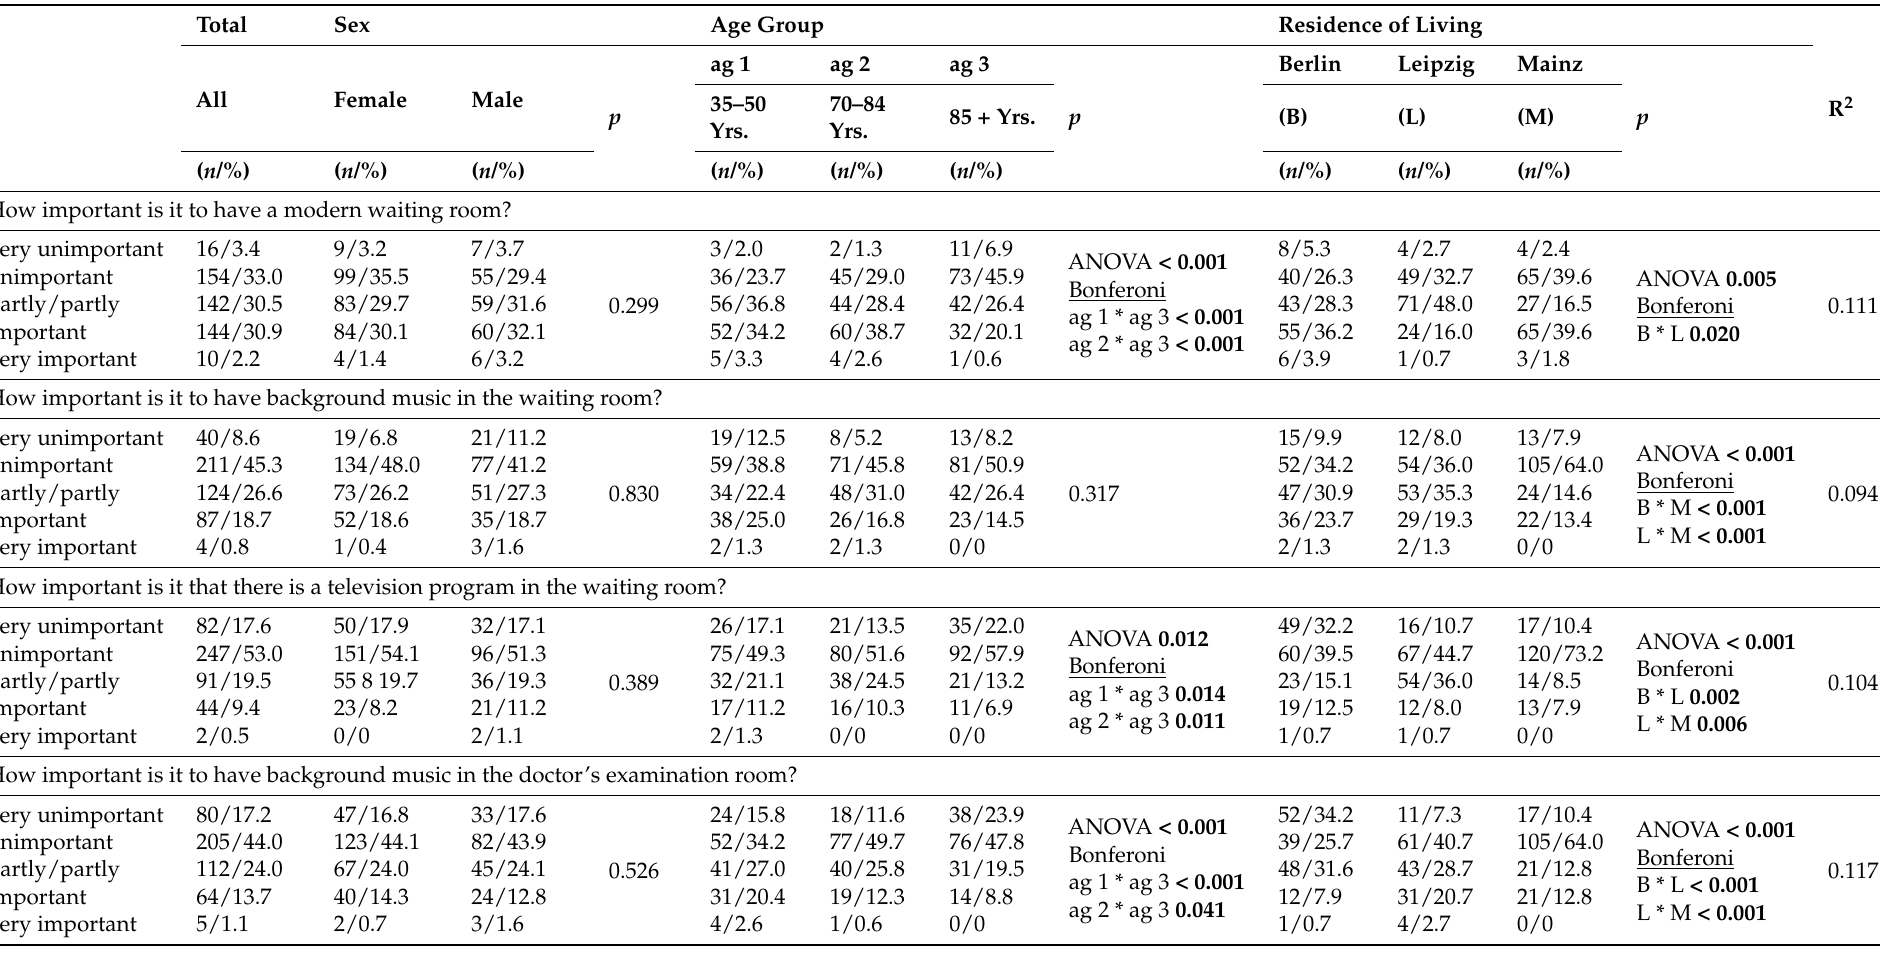
Table 3. Importance of dental office equipment, and human interactions as criteria for the choice of a dentist presented separately by gender (female n = 279,